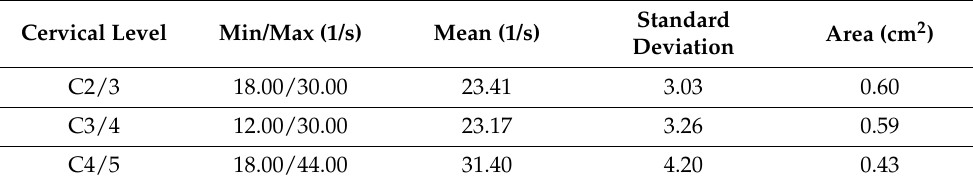
Table 6. Preliminary data obtained from our initial incomplete study, showcasing R2* region of interest (ROI) scores of a healthy recruit. Data obtained through a standardisation protocol of R2* using 3T MAGNETOM PRISMA MRI scanner. The values obtained from our R2* is equivalent to other soft tissues in the absence of pathological processes leading to iron deposition (based on R2* studies done in the brain and liver) which tends around 30. As such, we would expect higher R2* values in recruits with